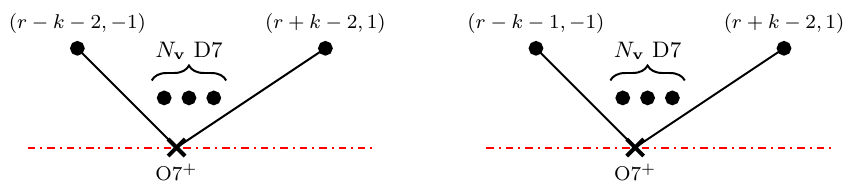
Figure 2 . Brane webs for pure SO( N ) gauge theory with N v hypermultiplets in the vector repre- sentation at the infinite gauge coupling limit for the case where N = 2 r (left) and N = 2 r +1 (right).